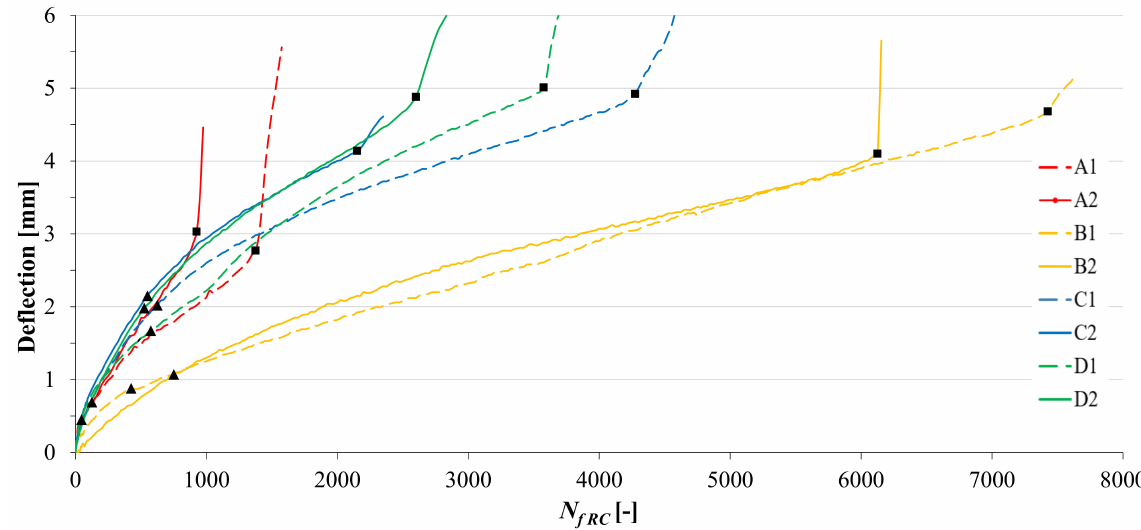
Figure 12. Results of the reflective cracking test.